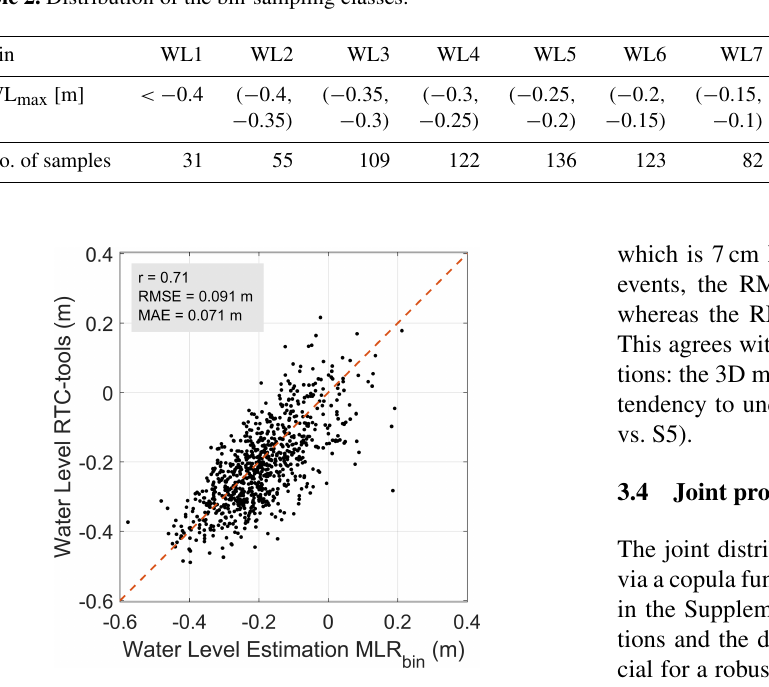
Figure 4. WL max obtained by RTC-Tools vs. WL max obtained us- ing MLR with the bin-sampling approach for the 2D case (see Ta- ble